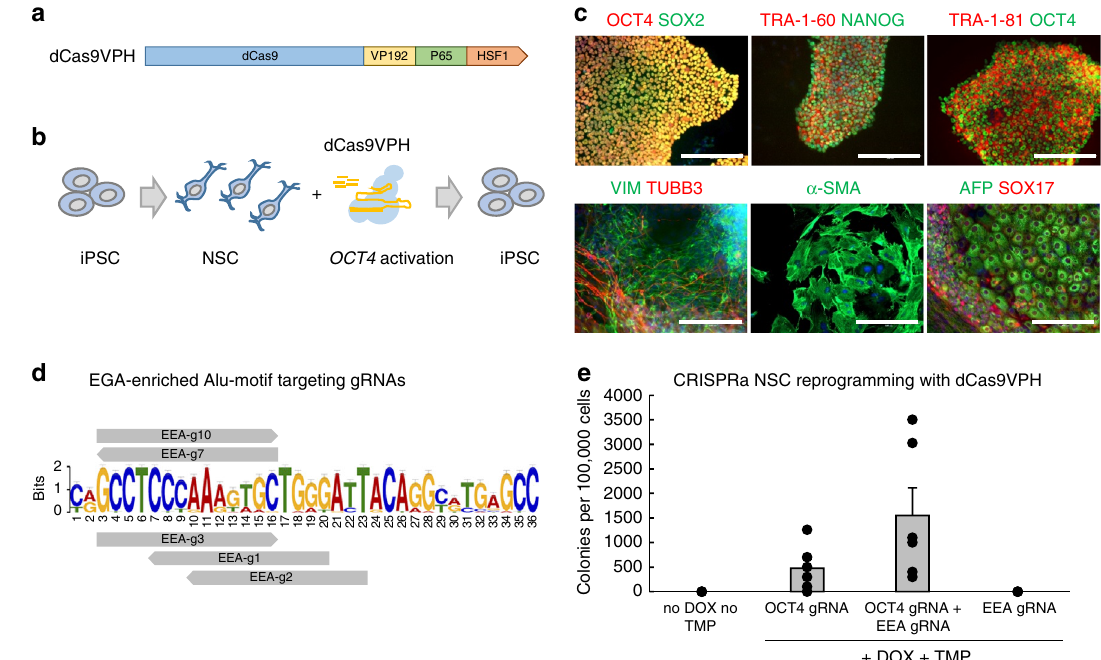
Fig. 1 CRISPRa-mediated reprogramming of NSCs and EEA-motif targeting. a Schematic representation of dCas9VPH structure. b Schematic representation of NSC reprogramming into iPSCs with dCas9VPH mediated OCT4 activation. c Immunocytochemical detection of pluripotency markers in NCS-derived iPSCs (top row) and tri-lineage differentiation in plated embryoid bodies (bottom row). Nuclei stained blue. Scale bar = 200 µ m. d Targeting of EGA enriched Alu-motif with SpdCas9 gRNAs. e Quanti fi cation of iPSC-like alkaline phosphatase positive colonies induced from NSCs. n = 6 independent inductions ( P = 0.053, OCT4 targeting with EEA-gRNAs vs. without EEA-gRNAs). Data presented as mean ± s.e.m., two-tailed Student ’ s t